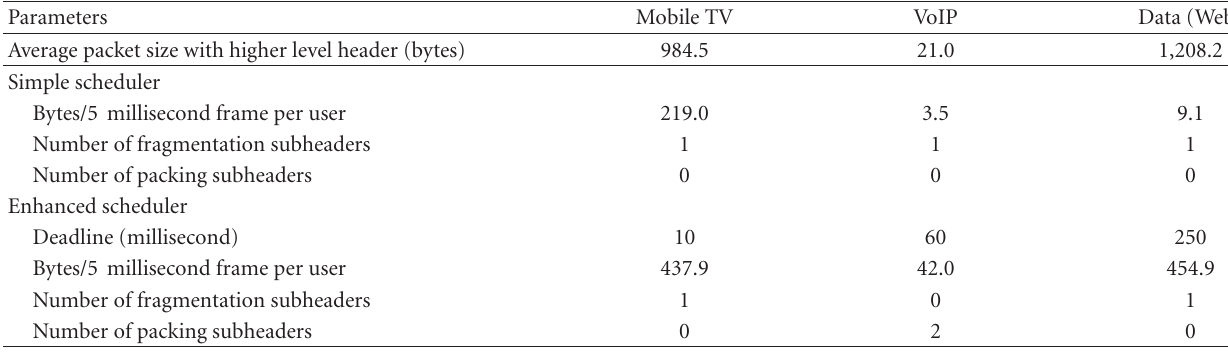
Table 9: Fragmentation and packing subheaders.